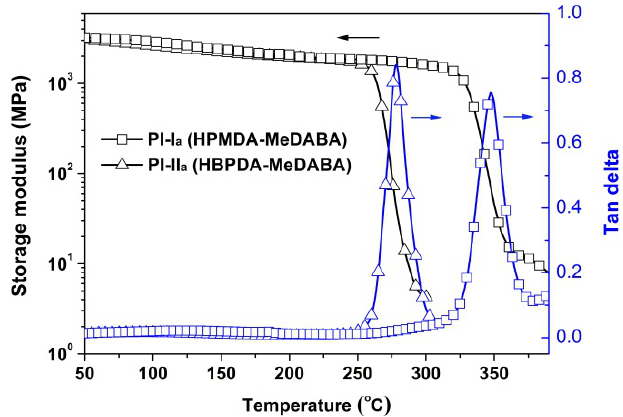
Figure 12. DMA curves of MeDABA-PI films.